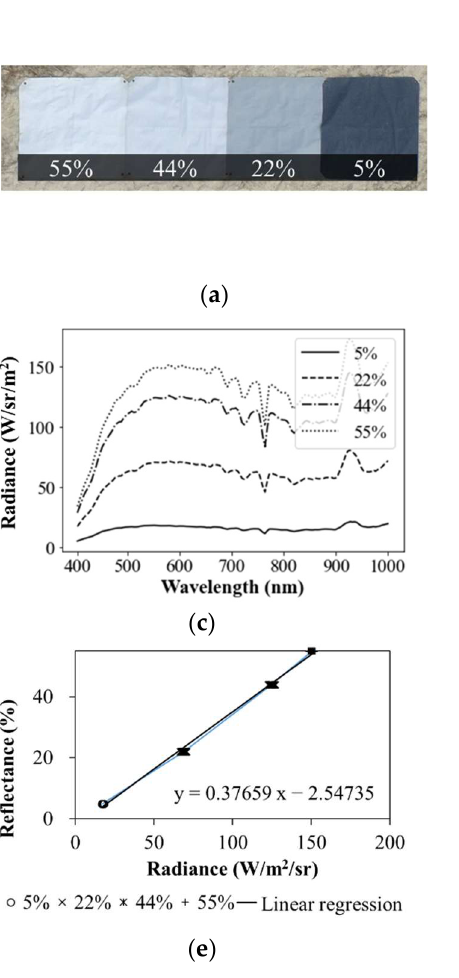
Figure 3. Derivation of radiometric calibration equation for a hyperspectral image using re- flectance tarps. ( a ) The reflectance tarps; ( b ) spectrometer data from reflectance tarps; ( c ) hyperspectral sensor data from reflectance tarps; ( d ) concept of radiometric calibration; ( e ) radiance to reflectance rating at 597.66 nm; ( f ) calibrated reflectance tarps from hyperspectral sensor.